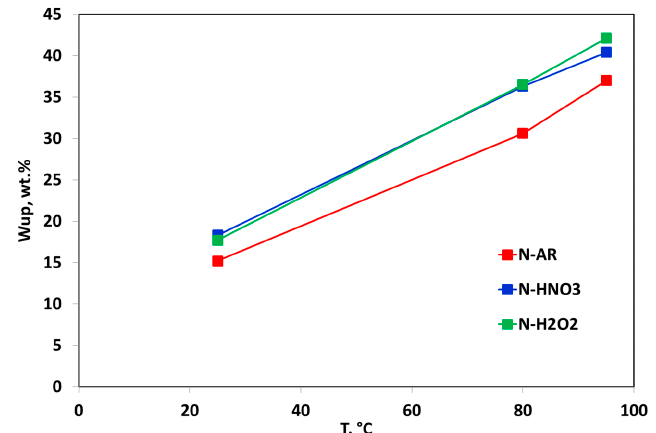
Figure 2. Comparison between Wup measured in liquid water at rT, 80 °C, 95 °C for N-AR (red squares), N-HNO3 (blue squares) and N-H2O2 (green squares) membranes.